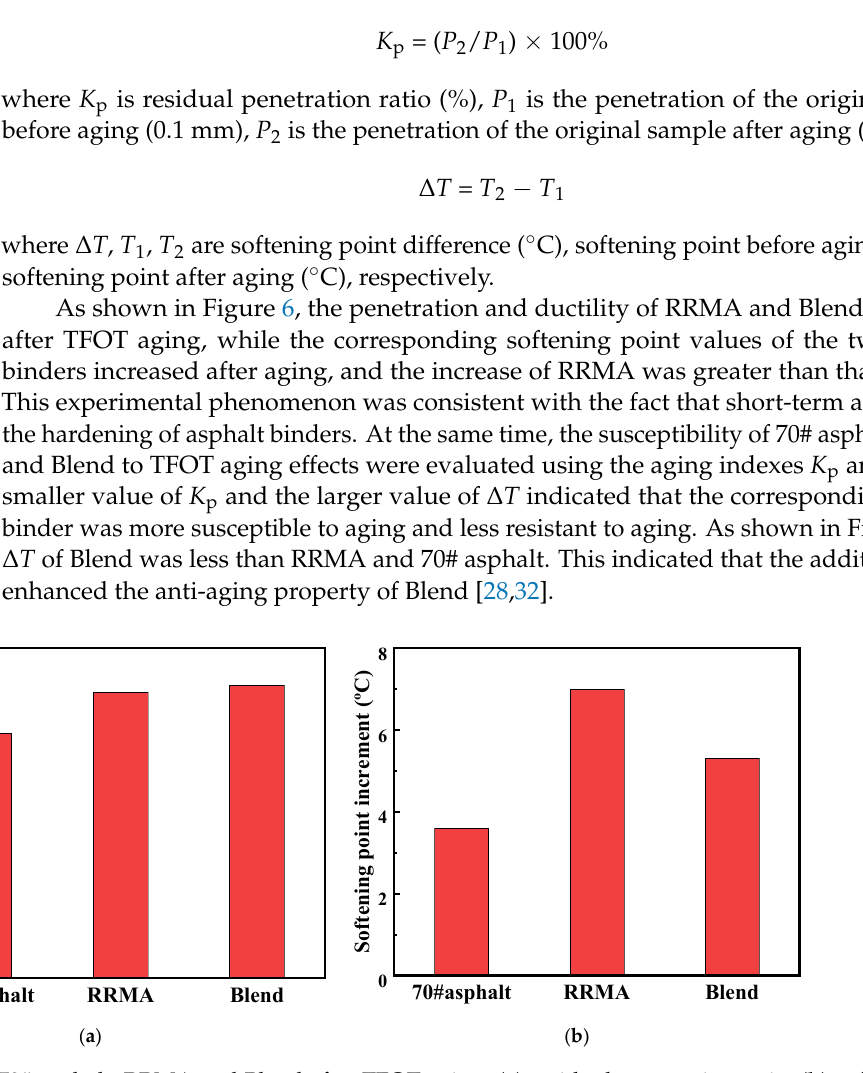
Figure 6. Aging indices of 70# asphalt, RRMA and Blend after TFOT aging: ( a ) residual penetration ratio; ( b ) softening point increment.